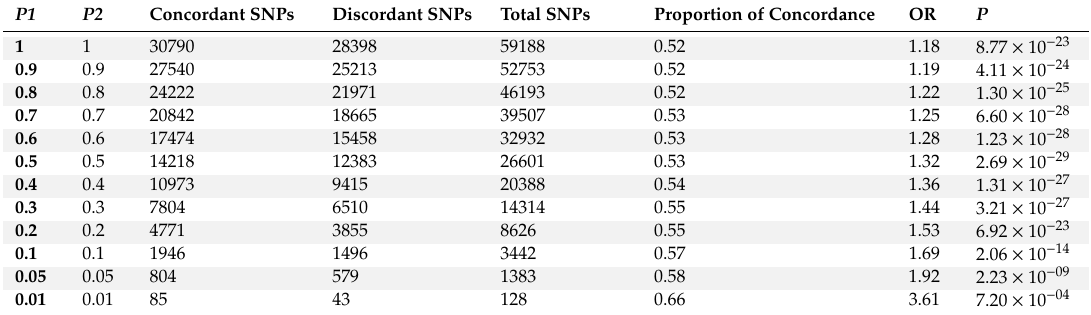
Table 1. SNP e ff ect concordance analysis (SECA) results for the test of genetic concordance between endometriosis and